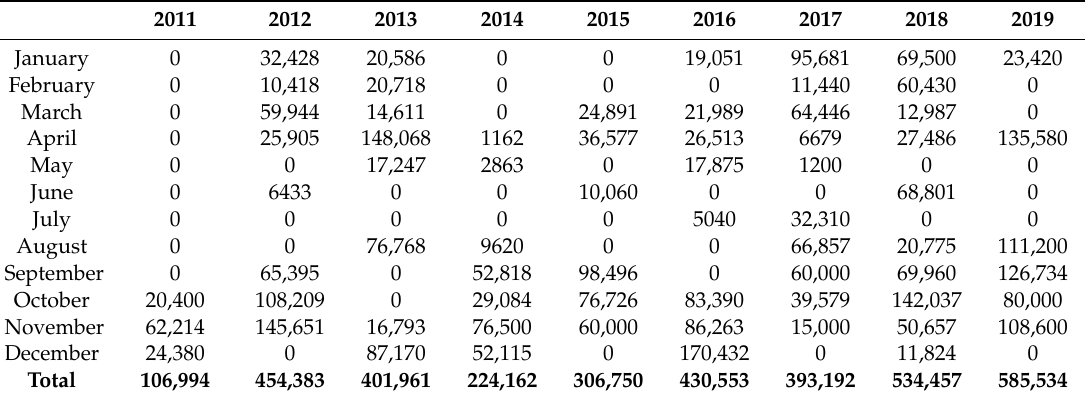
Figure5. EvolutionofthevolumeofwaterstoredmonthlyintheJos é ManuelObreroD í ezAnti-Pollution Figure 5. Evolution of the volume of water stored monthly in the José Manuel Obrero Díez Anti- Tank (2011–2019). Source: [42]. Own elaboration. Pollution Tank (2011–2019). Source: [42]. Own elaboration. Table 2. Evolution of stored rainwater in the Jos é Manuel Obrero D í ez Anti-Pollution Tank (2011–2019) (m 3